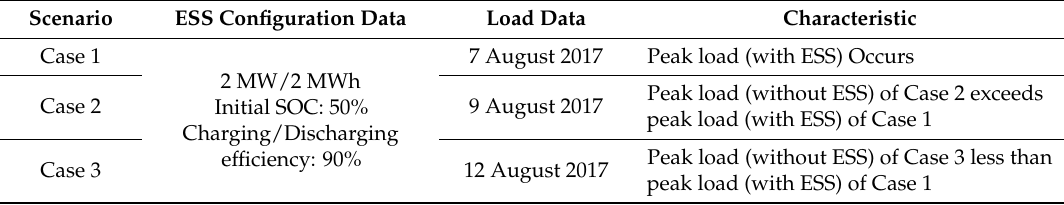
Table 8. Scenarios for ESS